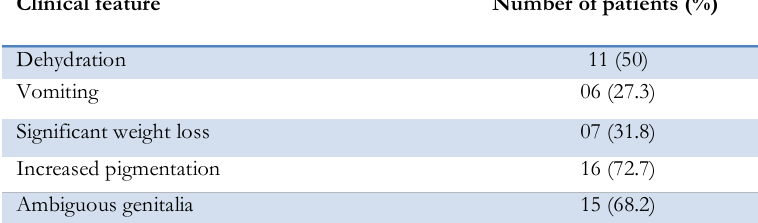
Table 2: Clinical features at presentation